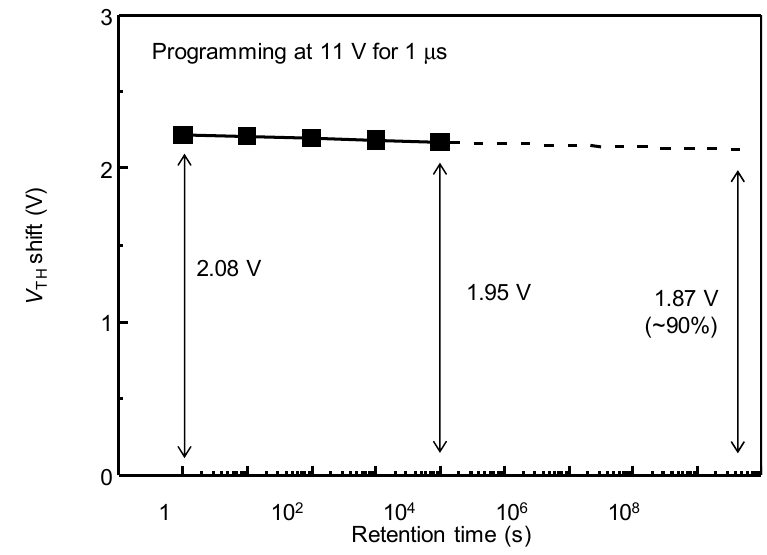
Figure7. Theextrapolatedretentioncharacteristicsupto10years(10 9 s)oftheMetal / SiO 2 / SiO X / SiO X N Y / Figure 7. The extrapolated retention characteristics up to 10 years (10 9 s) of the ITZO Metal/SiO 2 /SiO X /SiO X N Y /ITZO NVM.